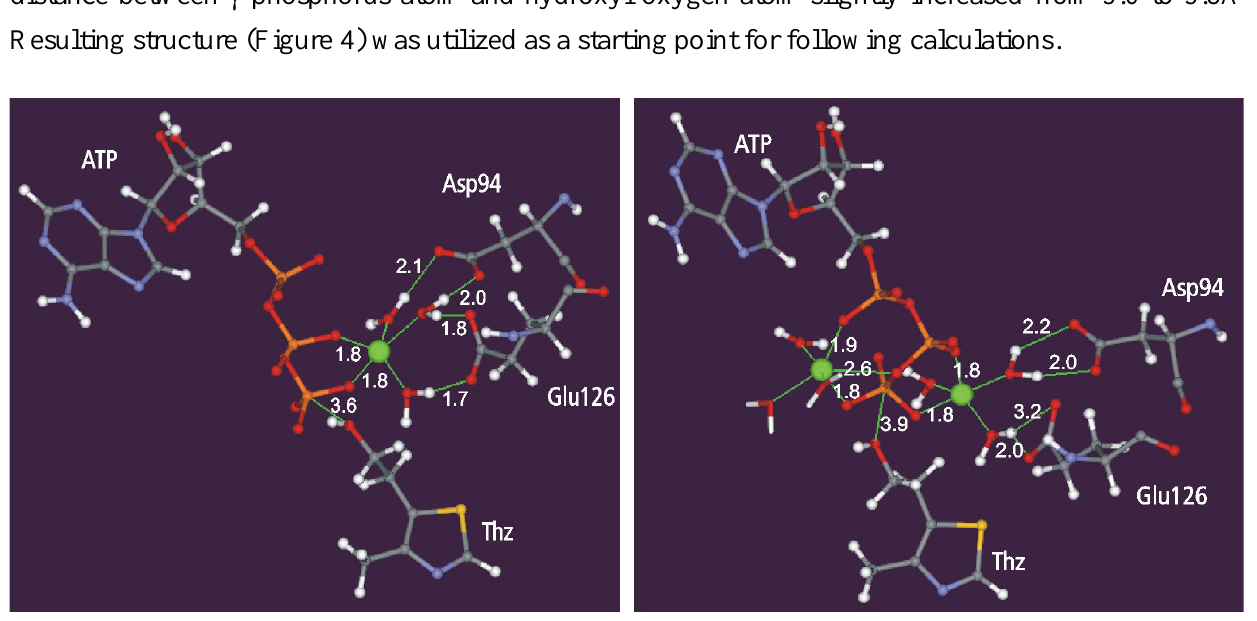
Figure 3. The closest contacts made by magnesium ions (presented as green balls). For distinction, the two non-crystalline water molecule are shown in stick representation. The missing values of marked distances are described in the text.